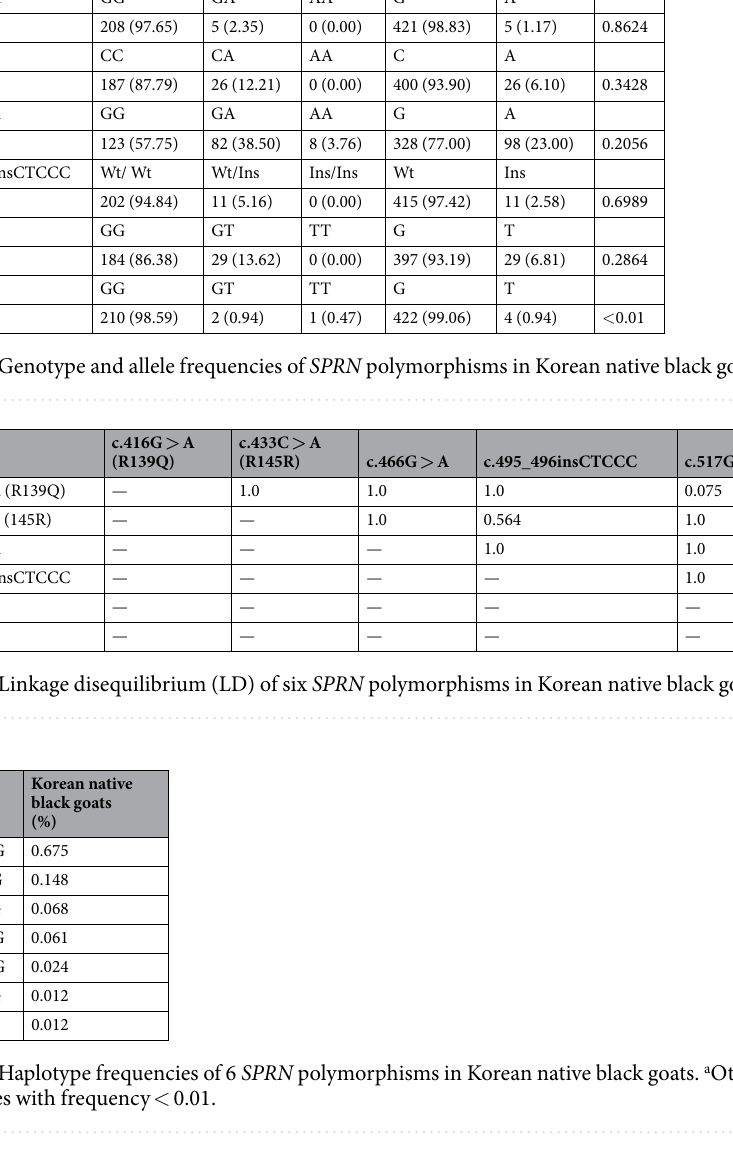
Table 2. As shown in Table 3, 6 major haplotypes were identified in Korean native black goats. Among the 6 haplotypes, the GCGWtGG haplotype was most frequently observed (67.5%), followed by GCAWtGG (14.8%), GCAWtAG (6.8%) and GAGWtGG (6.1%, Table 3). In addition, we compared the allele frequencies of the c.495_496insCTCCC indel polymorphism of the SPRN gene between Italian goats 20 and Korean native black goats (Fig. 2). The c.495_496insCTCCC indel polymor- phism is well known for a relationship with scrapie susceptibility in Italian goats, where a significant difference in the allele frequency of c.495_496insCTCCC was found between scrapie-affected goats and healthy goats (P = 0.002) 20 . This result suggests that the c.495_496insCTCCC allele is associated with scrapie susceptibility. Interestingly, the allele frequency of the c.495_496insCTCCC indel polymorphism in Korean native black goats was significantly lower than in both heathy and scrapie-affected Italian goats (P < 0.001). Furthermore, we estimated the impact of the nonsynonymous SNP c.416G > A (Arg139Gln) on the Sho protein using the PROVEAN program. PROVEAN predicted that R139Q was ‘Neutral’ with a score of − 0.297 (Table 4).